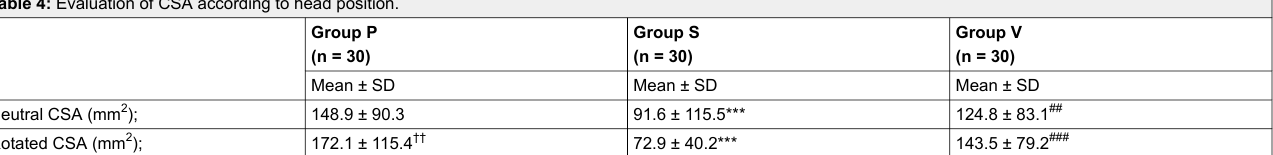
Group P: pressure-controlled ventilation Group S: spontaneous ventilation Group V: volume-controlled ventilation CSA = cross-sectional area; SD = standard